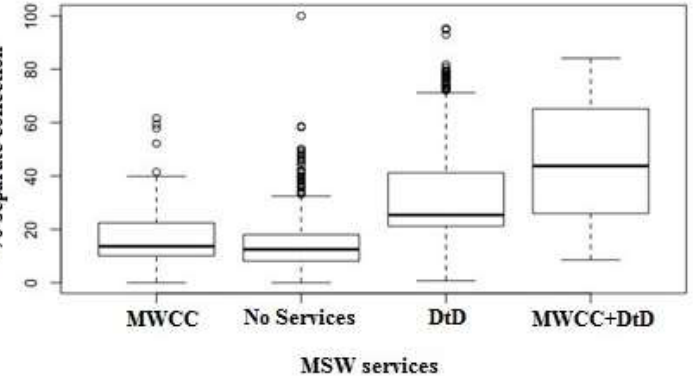
Figure 9. Boxplot percentage of separate collection comparing the presence of door-to-door service or municipal waste collection centers.